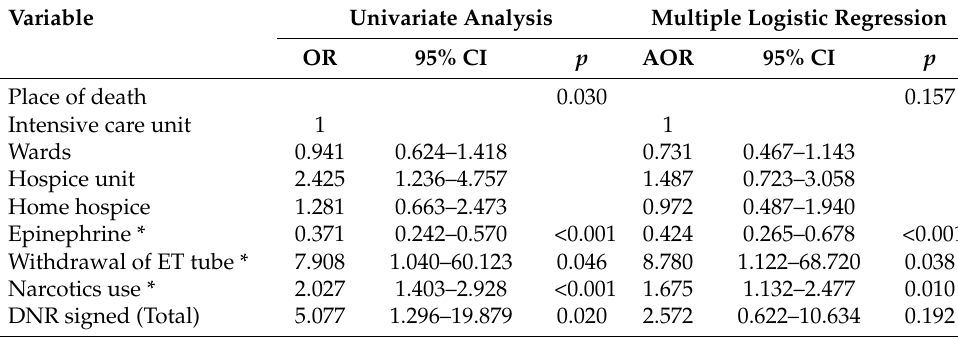
Table 5. Multiple logistic regression analyses of end-of-life care between 362 ED-PC patients with mortality and 172 UC patients with mortality.